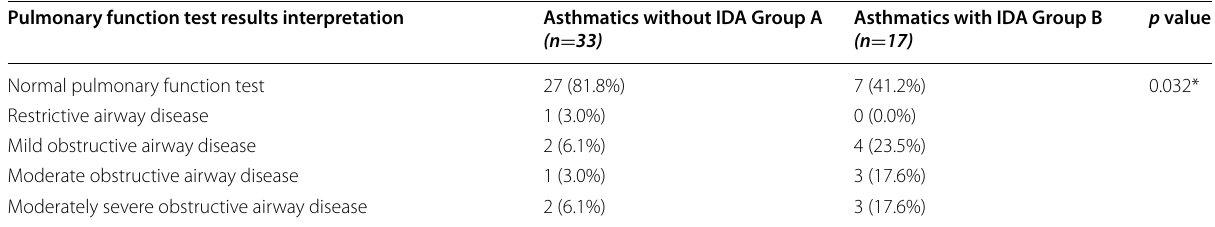
Table 2 Comparison between asthmatics without IDA and asthmatics with IDA according to the pulmonary function test results